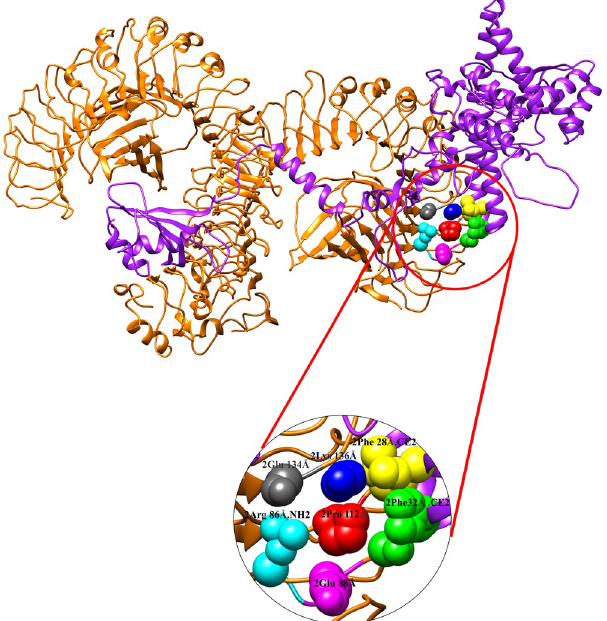
Figure 5. Binding site prediction by using CASTp server. Total two binding sites has been obtained where Grey, blue and yellow color residues showing the first binding pocket; green, magenta, cyan and red colored amino acid residues representing the second binding site.